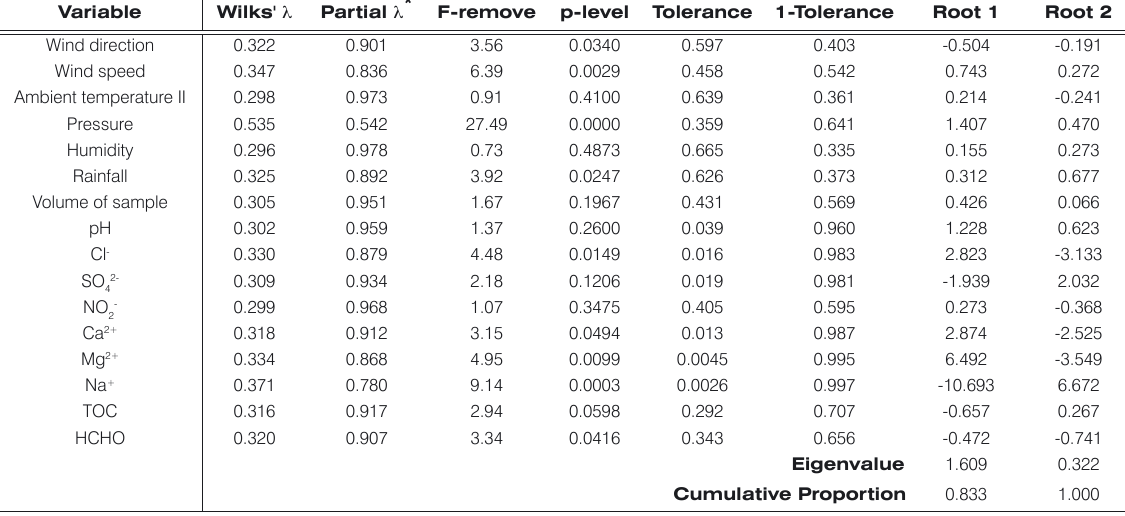
Table 5 . Variables in the model (Gdynia 1, Gdynia 2 and Sopot) and the standardized canonical discriminant function coefficients Variable Wind direction